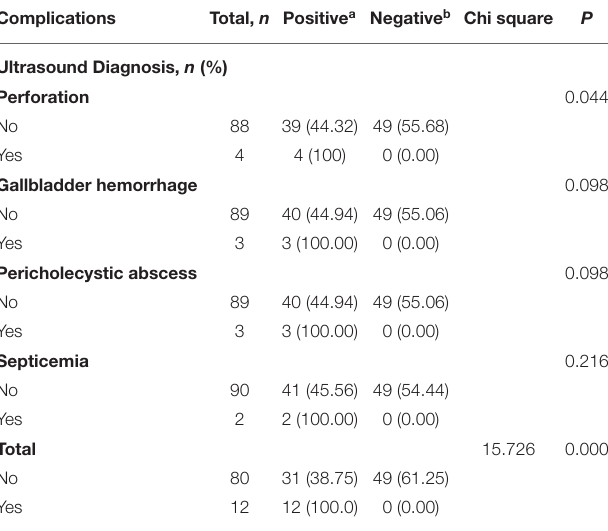
TABLE 3 | Summary of complications by ultrasound in acute acalculous cholecystitis (AAC) positive and negative groups.